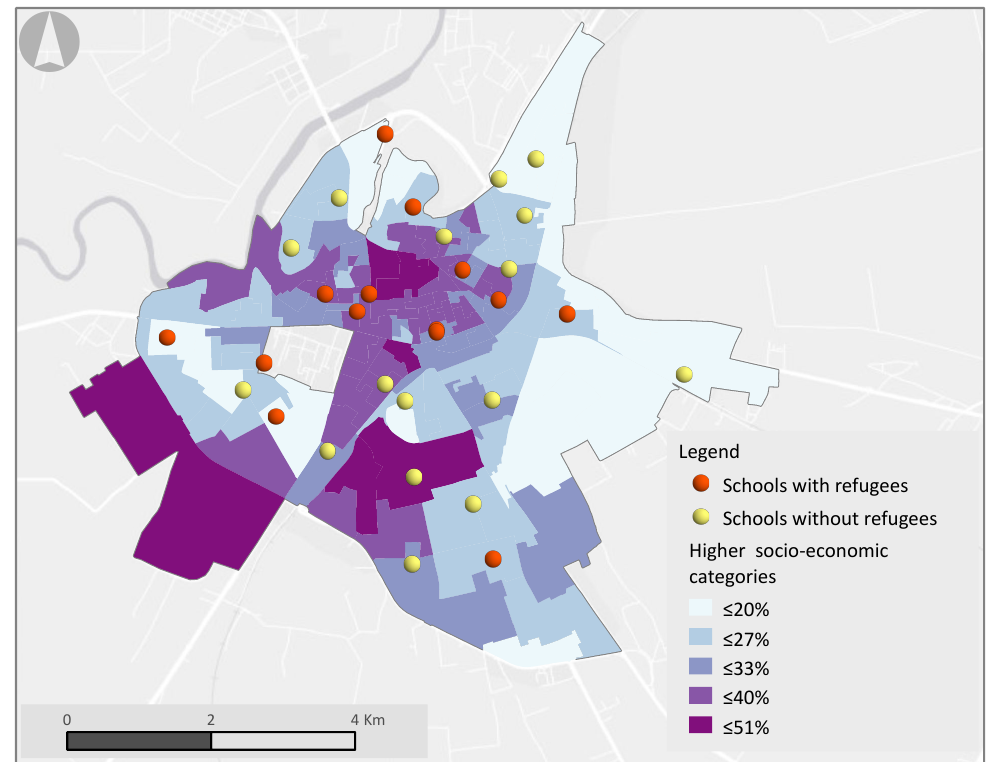
Figure 2. Distribution of higher socio-economic categories (2011) and refugee school population in Larisa. Source: Authors’ elaboration and EKKE–ELSTAT (2015).